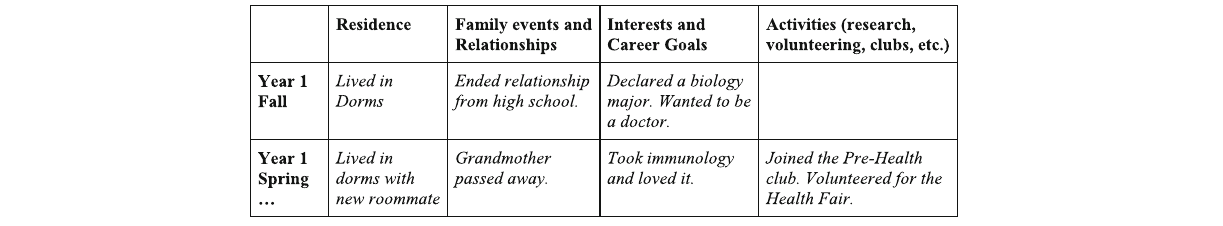
Column 1 shows times that are relevant to the study. Columns 2 and 3 represent indirect indicators. Columns 4 and 5 represent direct indicators. Fictitious representative responses are italicized. Blank spaces exist and are expected in the biology life grid